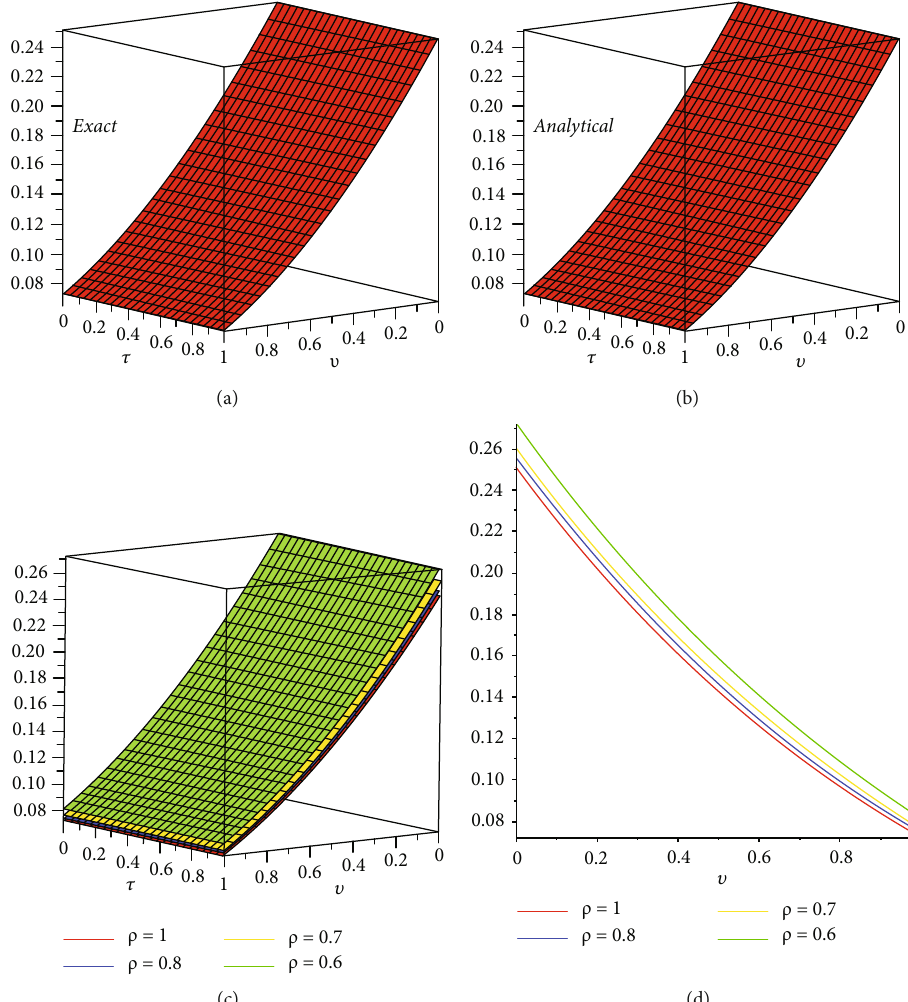
Figure 2: The graphical layout of the exact solution, proposed method solution at ρ = 1 and at various fractional orders of ρ = 1,0 : 8,0 : 6,0 : 4 with c = 0 : 5 for problem